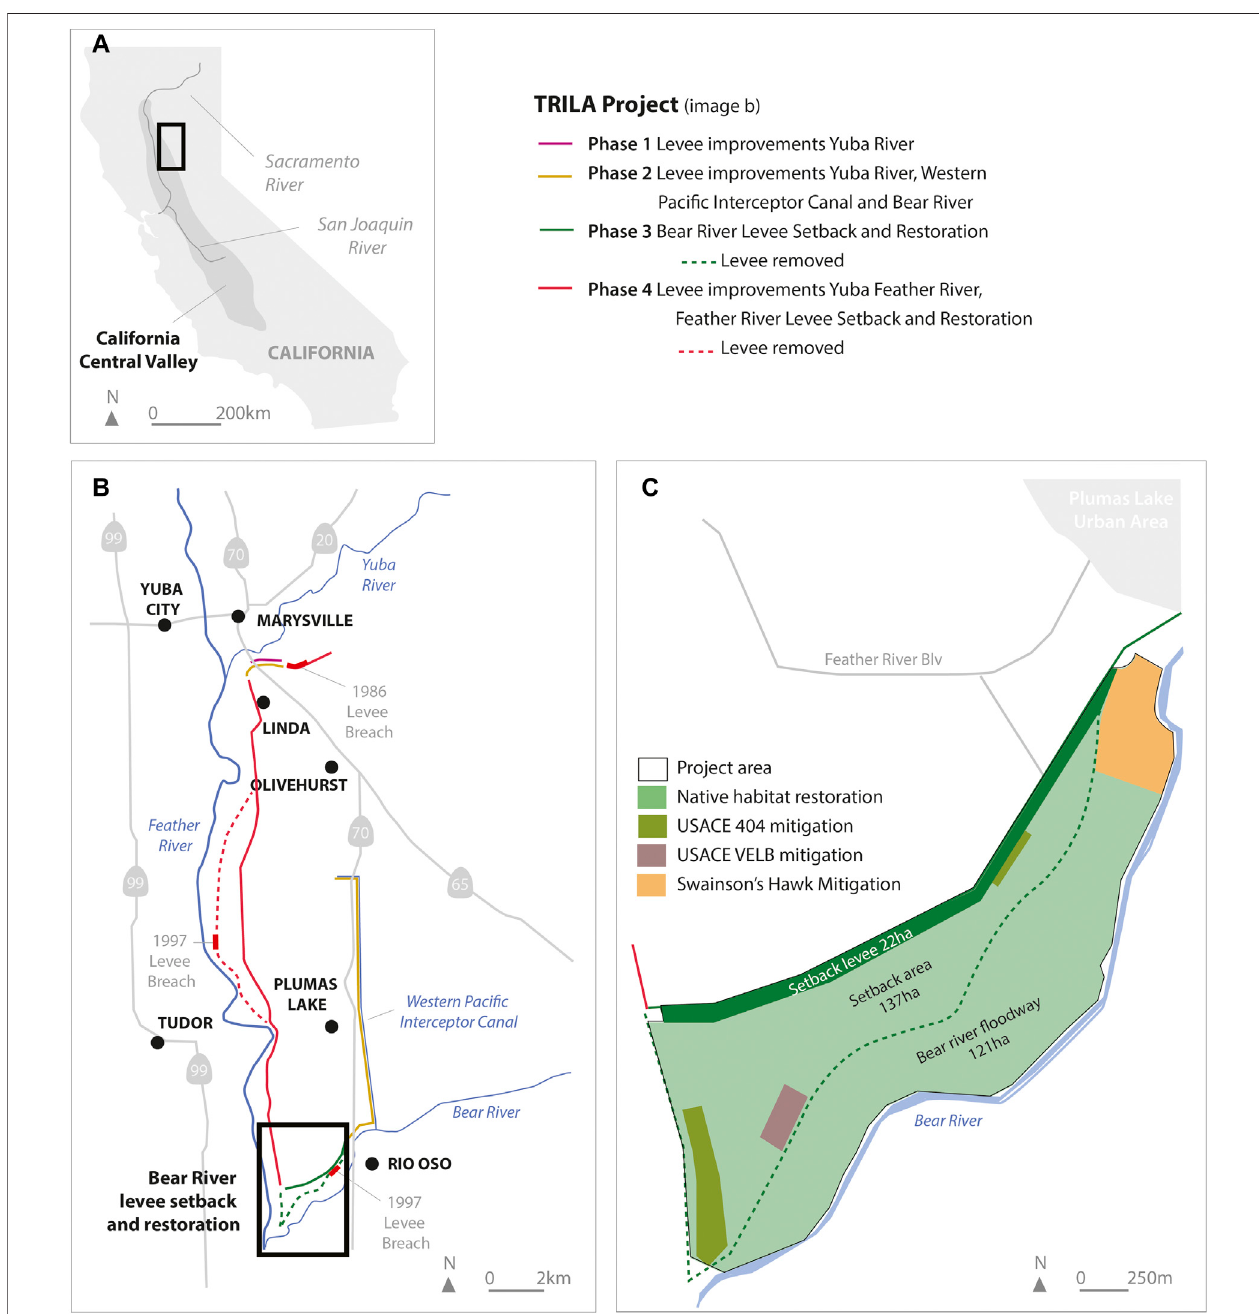
FIGURE 5 | Bear River Levee Setback Project, Yuba and Sutter Counties, California. (A) Location Map, (B) Regional Map, and (C) Bear River Levee Setback and Floodplain Restoration Project.